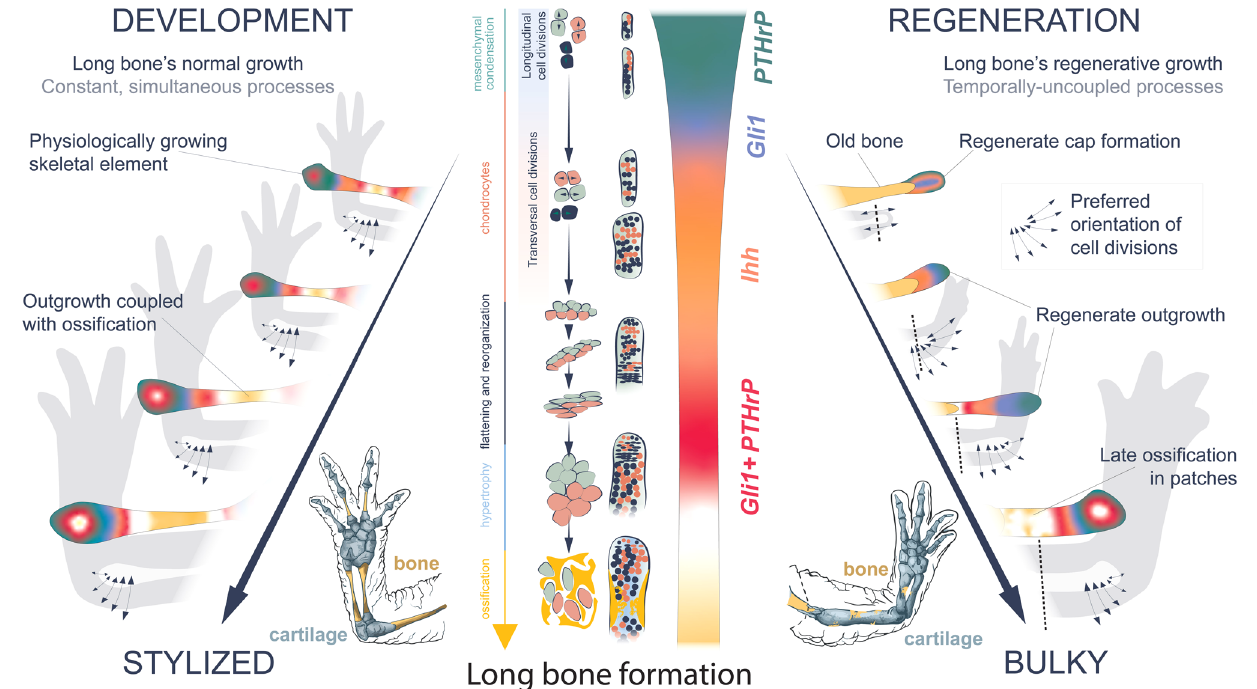
Fig. 7 | Graphical Abstract. Summary of similarities and differences between skeletal development and